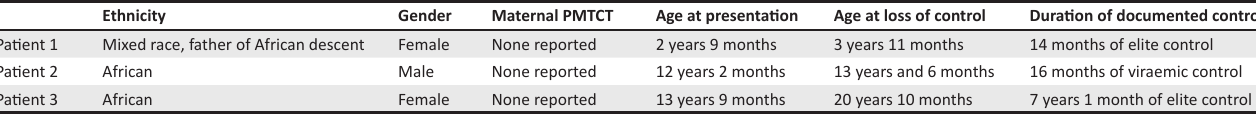
TABLE 1: Patient demographics and duration of control. Ethnicity Gender Maternal PMTCT Age at presentation Age at loss of control Duration of documented control Patient